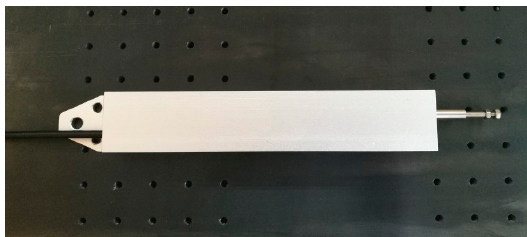
Figure 5. Photo of the FBG displacement sensor.